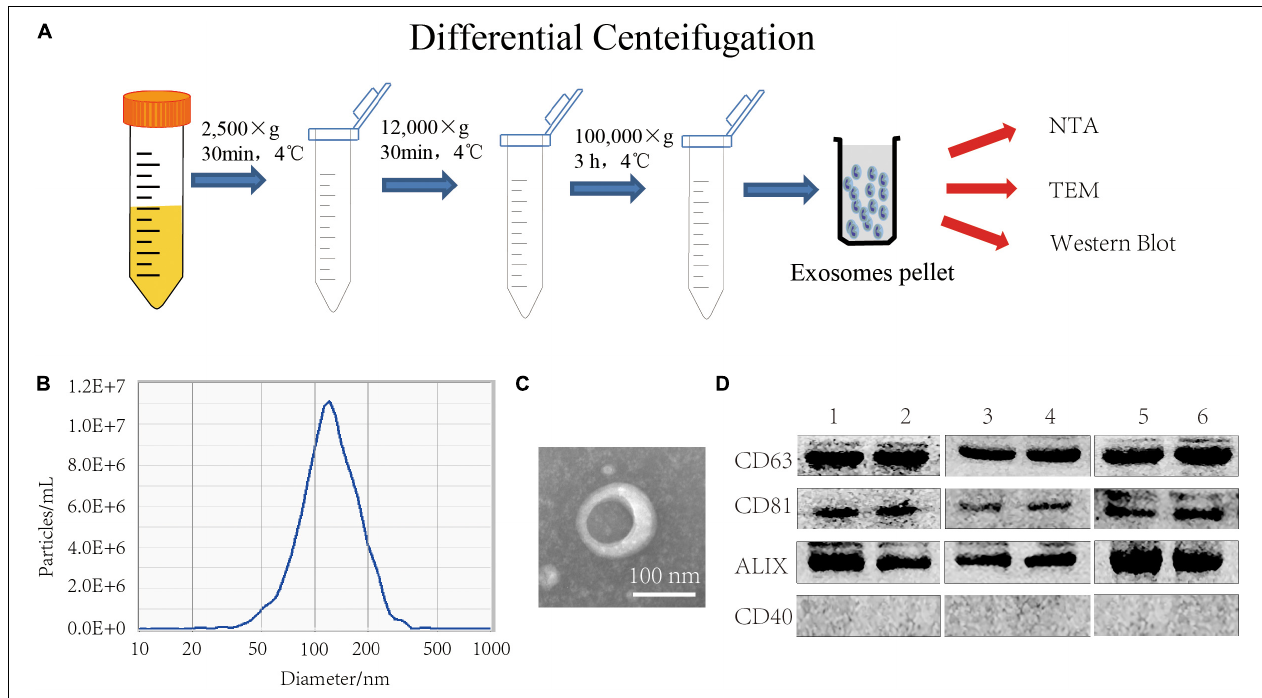
FIGURE 2 | FBS EXO extraction and identification. (A) Centrifugation; (B) NTA detection of the median particle size of FBS EXO; (C) Observation of FBS EXO structure under TEM ( × 100,000); (D) Western Blotting was used to detect the protein expression of exosome markers CD63, CD81, and ALIX and the microcapsule surface marker CD40 in different batches of FBS EXO, 1-6 represented exosomes extracted from different